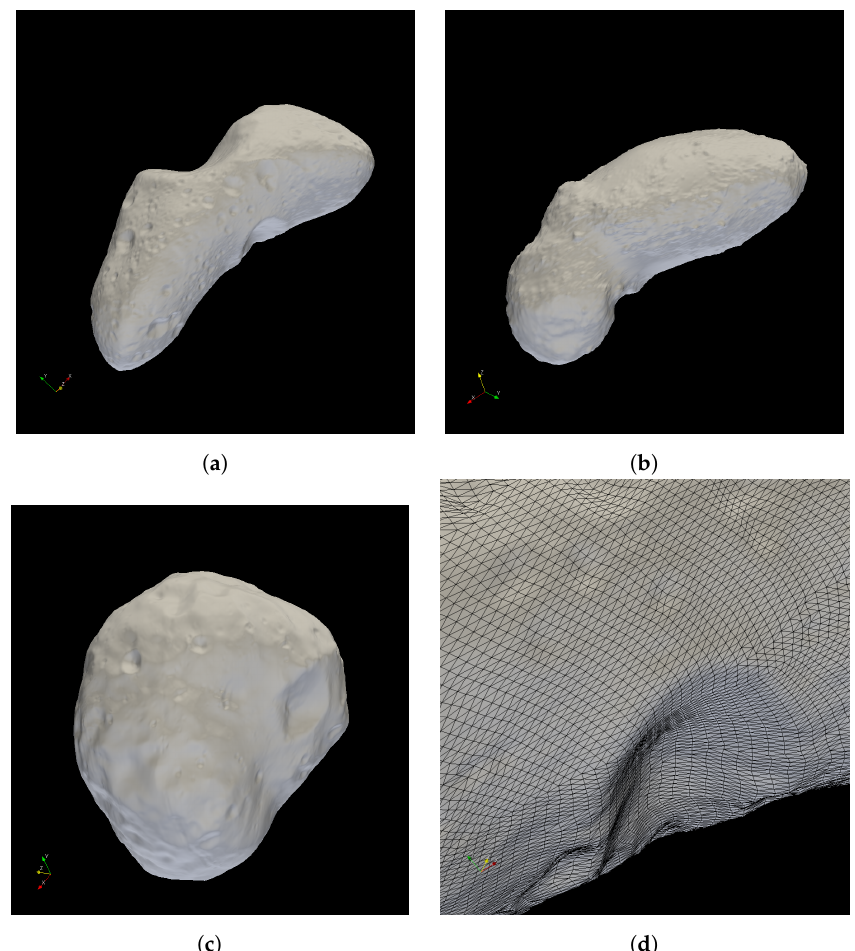
Figure 2. Surface triangulations of small bodies E ROS , I TOKAWA and Phobos. Average edge lengths are calculated from the average triangle area, assuming equilateral triangles. Thus, the values for average edge lengths are of a correct order of magnitude. ( a ) Asteroid (433) E ROS . 196,608 faces, average triangle area 5771 m 2 , average edge length approx. 115 m [16]; ( b ) Asteroid (25143) I TOKAWA , 196,608 faces, average triangle area 2 m 2 , average edge length approx. 2 m [4]; ( c ) Martian satellite Phobos, 49,152 faces, average triangle area 33,500 m 2 , average edge length approx. 278 m [17]; ( d ) close-up of triangle patches on E ROS ’s surface, average triangle area 22,982 m 2 , average edge length approx. 230 m